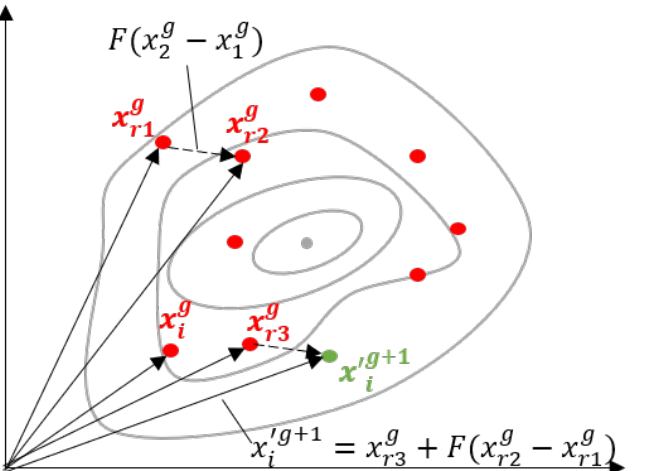
Figure 2. Example of Differential Evolution mutation in 2D (DE/rand/1/bin) (Adapted by permis- sion from licensor: Springer Nature, Journal of Global Optimization, 1997 [31] https://www.springer. com/journal/10898 accessed on 18 February 21).